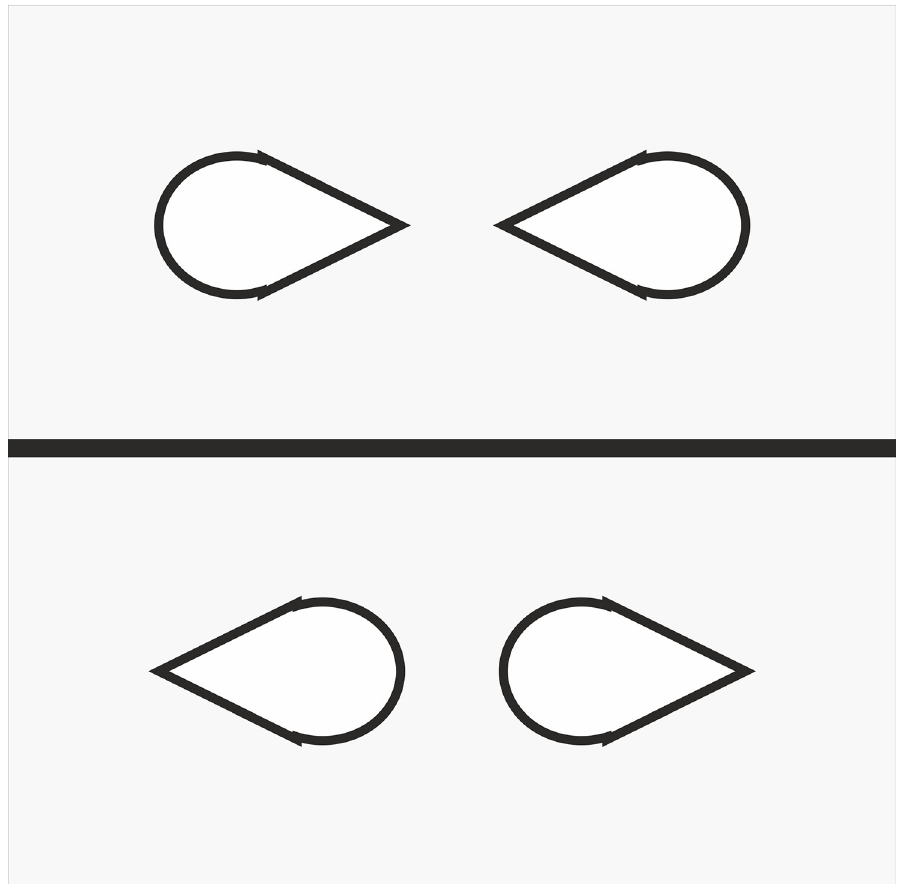
Fig 9. Schematic of the target pair presentations for the target orientation